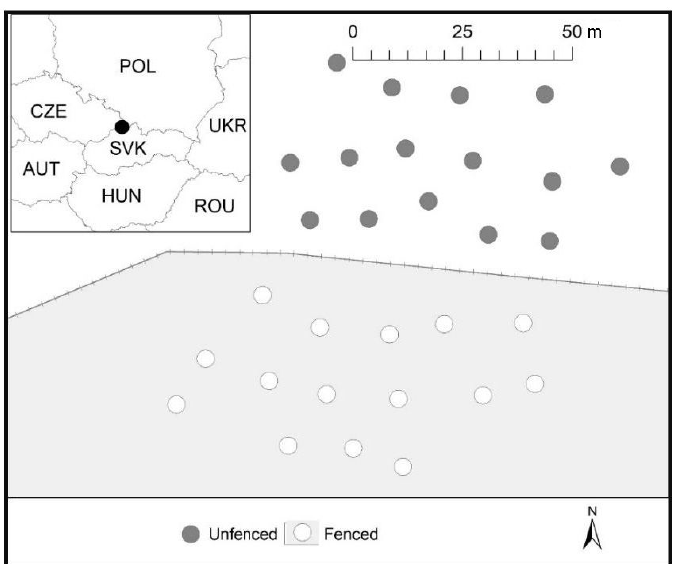
Figure 1. Location of the study area in the Kysuce region, northern Slovakia, and the sampling design where white circles indicate 2 m radius plots within area excluded from large herbivores (hatched line indicates fencing) and dark circles indicate plots open to herbivory.